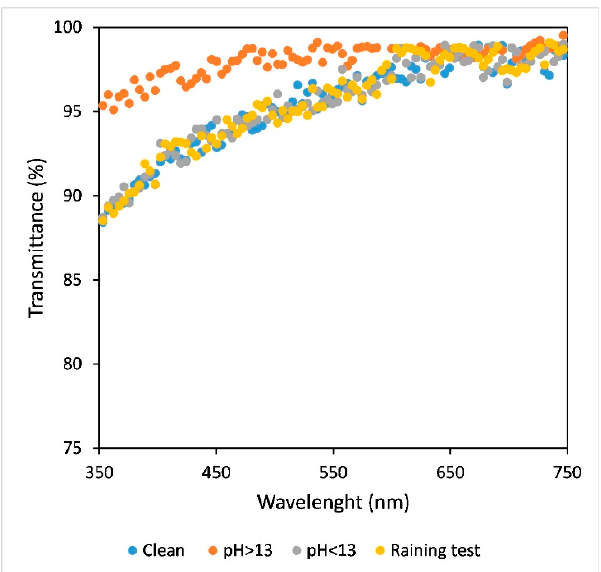
Figure 12. Transmittance spectra of clean SH coating as Figure 9 (blue dots) and SH coating after durability test: raining test (yellow dots), 24 h of immersion in solution with pH < 13 (grey dots) and pH > 13 (orange dots).